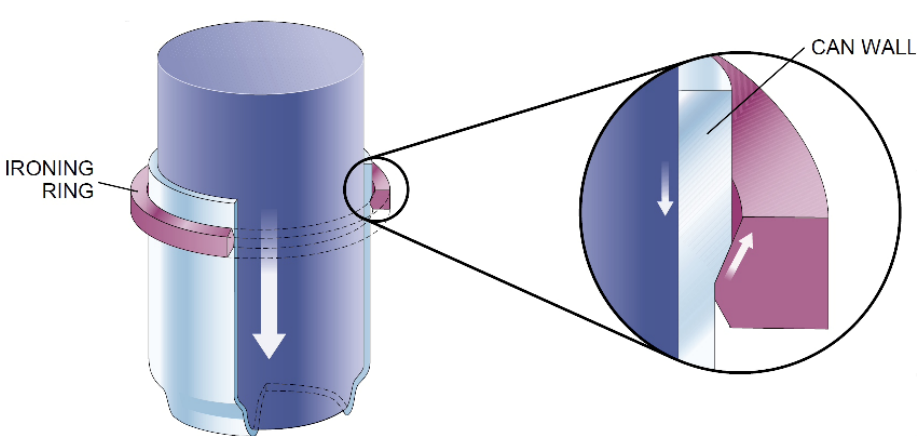
Figure 1. The ironing process in can manufacture. Source: Hosford and Duncan, Scientific American